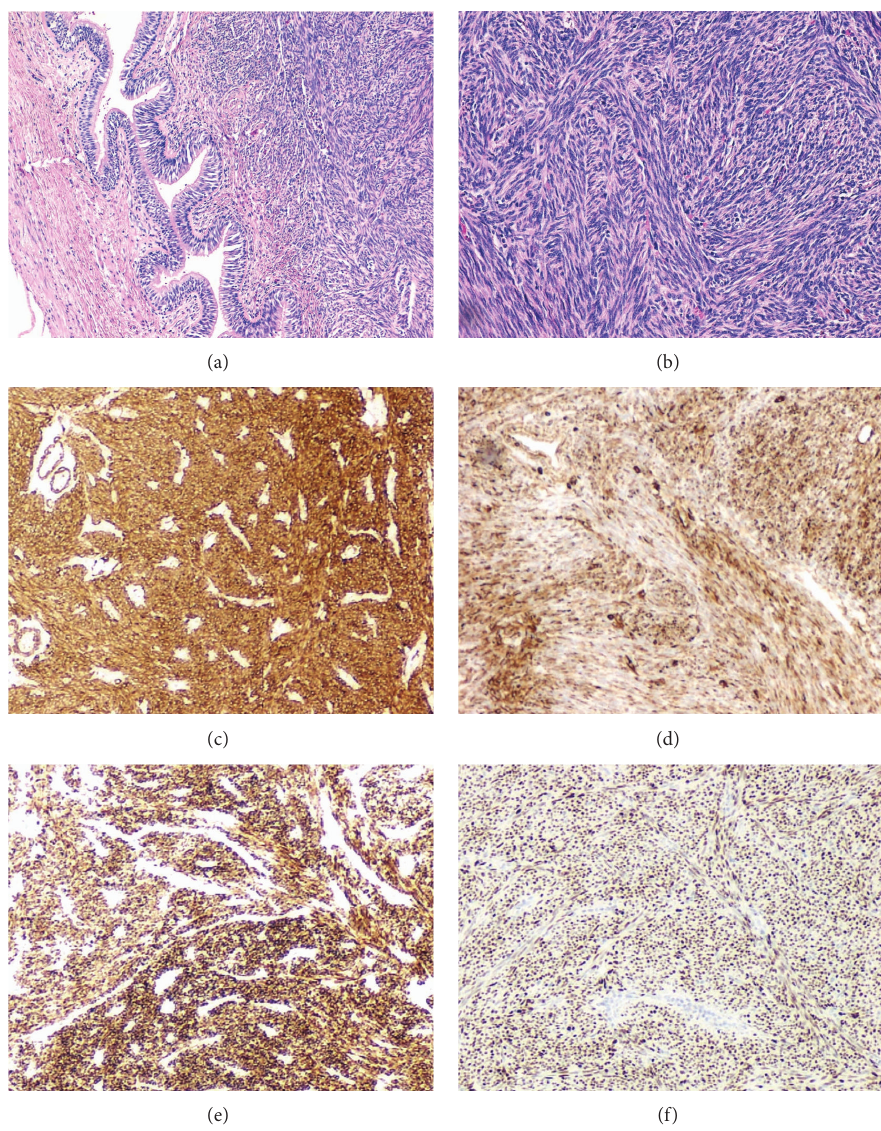
Figure 4: (a) Hematoxylin and Eosin (H&E) stain at low magnification showing two foci of BML. (b) H&E stain at a higher magnification showing trabeculated arrangement of spindle cells. (c), (d), (e), and (f) Immunohistochemical staining positive for SMA, vimentin, desmin, and CK